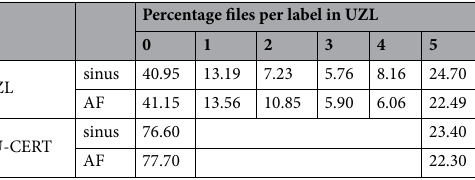
Table 2. Percentage of leads per label in the UZL and EU-CERT datasets, both for sinus and AF